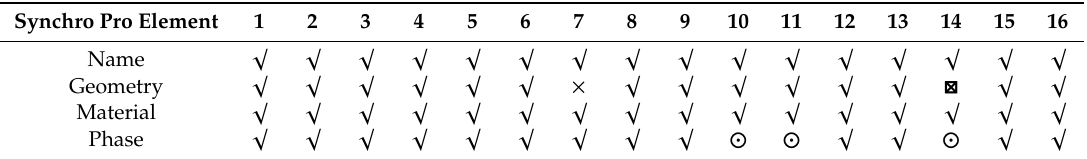
Table 3. Results of tests of BIM interoperability through the IFC standard, obtained by importing √ the sample IFC model into Synchro Pro ( : good interoperability; (cid:2) : medium interoperability; × : poor interoperability; (cid:12) : no data found).